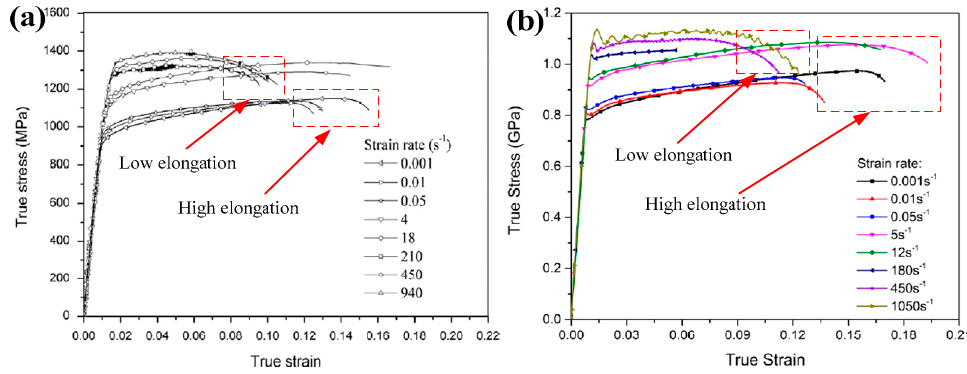
Figure 1. Tensile stress-strain curves of ( a ) Ti-6.6Al-3.3Mo-1.8Zr-0.29Si (TC11) alloy (Reprinted with